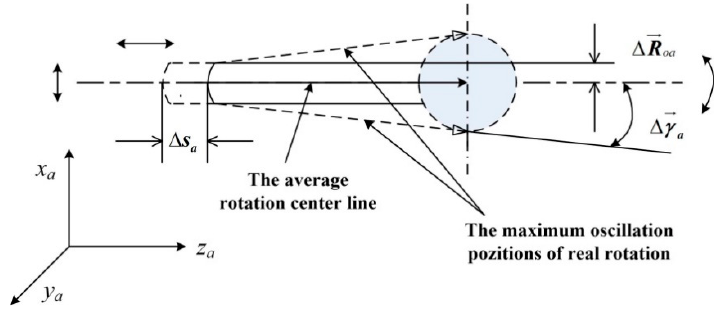
Figure 11. The assembly errors of azimuth run-outs.